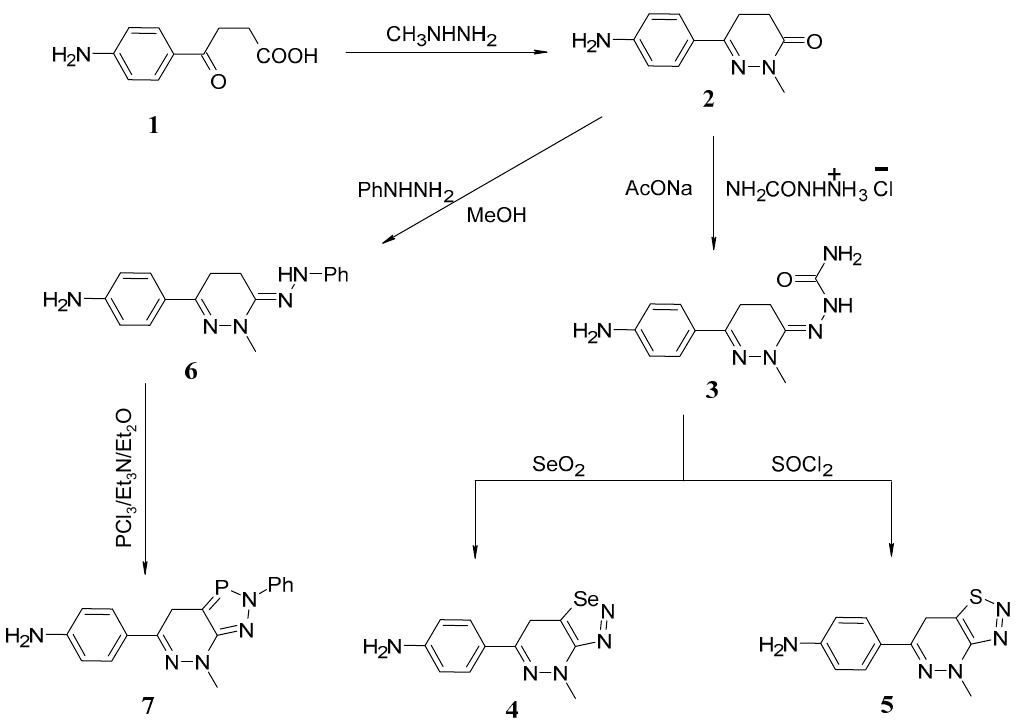
Molecules 2023 , 28 , x FOR PEER